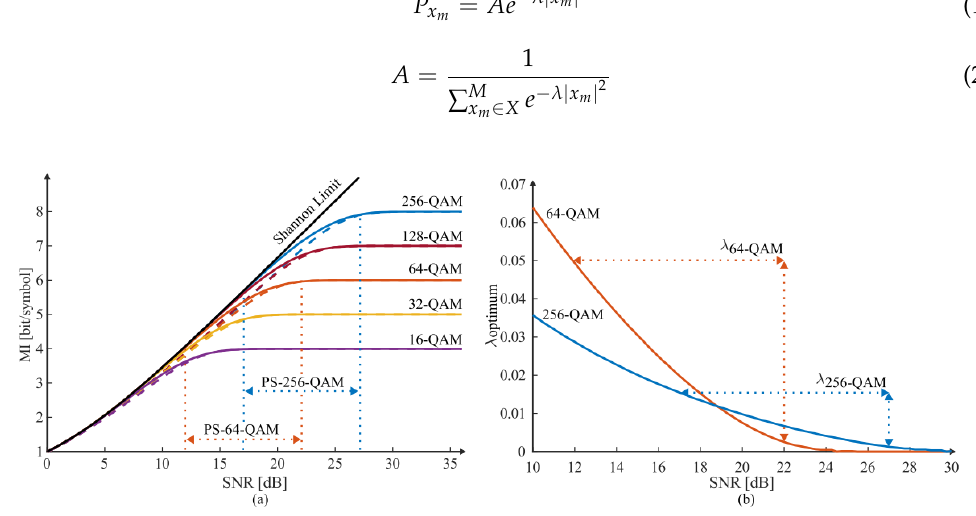
Figure 1. ( a ) MI for typical M-QAM formats and ( b ) optimal values of lambda for PS-64QAM